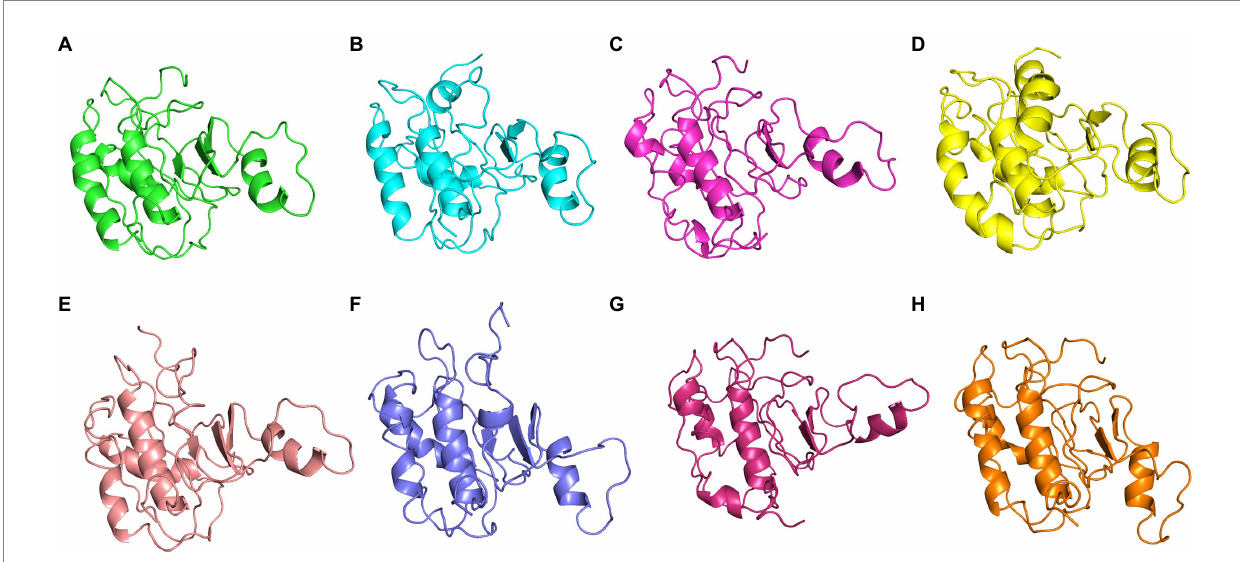
FIGURE 9 The centroid structure of each cluster obtained from the clustering of ASP_NL4-3 trajectory (A) Cluster 1 (C1)—5,940th ps, (B) Cluster 2 (C2) 11,600th ps, (C) Cluster 3 (C3) 13,640th ps, (D) Cluster 4 (C4) 1,200th ps, (E) Cluster 5 (C5) 33,500th ps, (F) Cluster 6 (C6) 13,750th ps, (G) Cluster 7 (C7) 31,500th ps, and (H) Cluster 8 (C8) 98,400th ps.